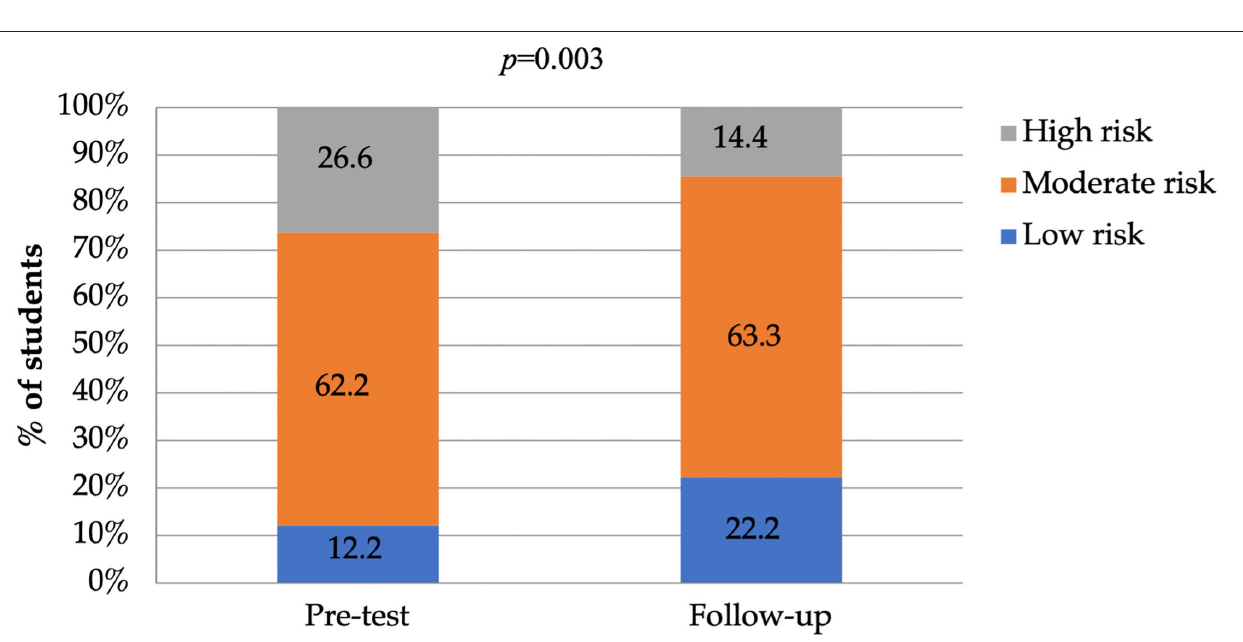
FIGURE 3 | Risk of high-salt consumption categories for student’s pre-test and at 4-weeks follow up (low risk, moderate risk, and high risk). The p -value indicates the statistical significance of the McNemar test.